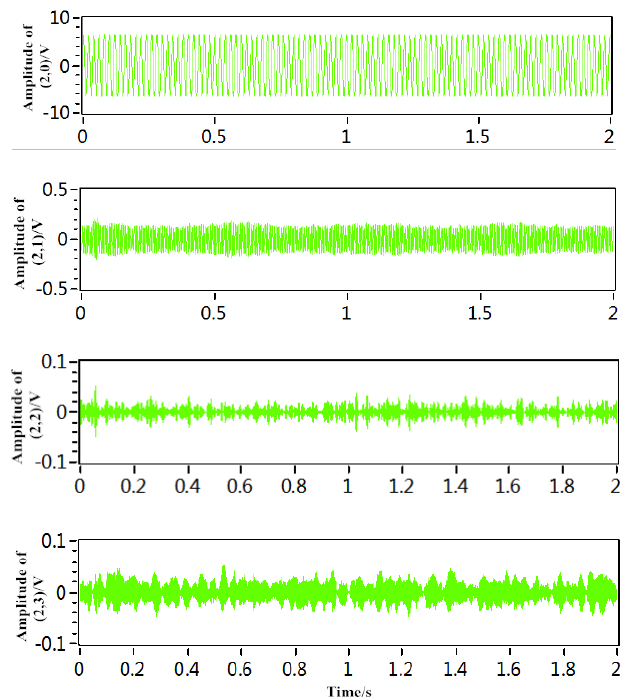
Figure 8. Reconstruction signals of the current of the fault motor.